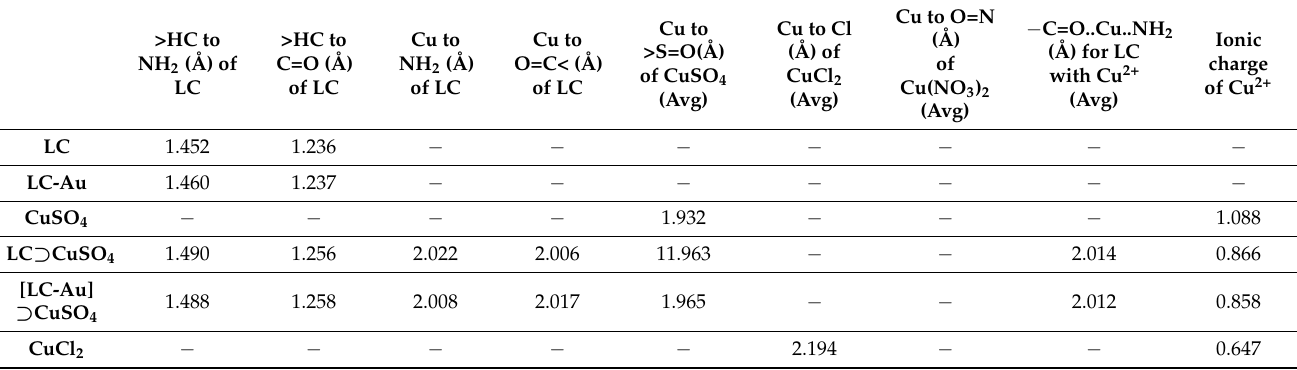
Table 4. DFT-calculated selected bond distances (in angstroms (Å)) for the selected atoms of LC; LC-Au; CuSO 4 ; CuSO 4 ; Cu(NO 3 ) 2 ; CuCl 2 and their 1:1 complex at the ω B97XD/LANL2DZ level of theory in the water solvent